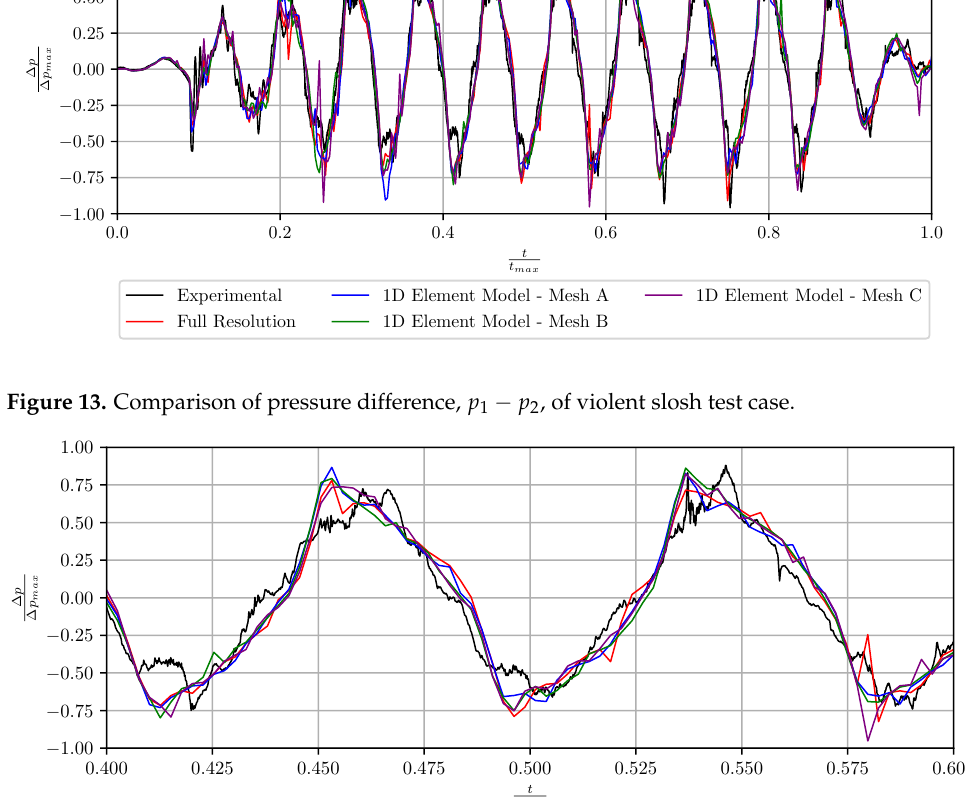
Figure 14. Enlarged comparison of pressure difference, p 1